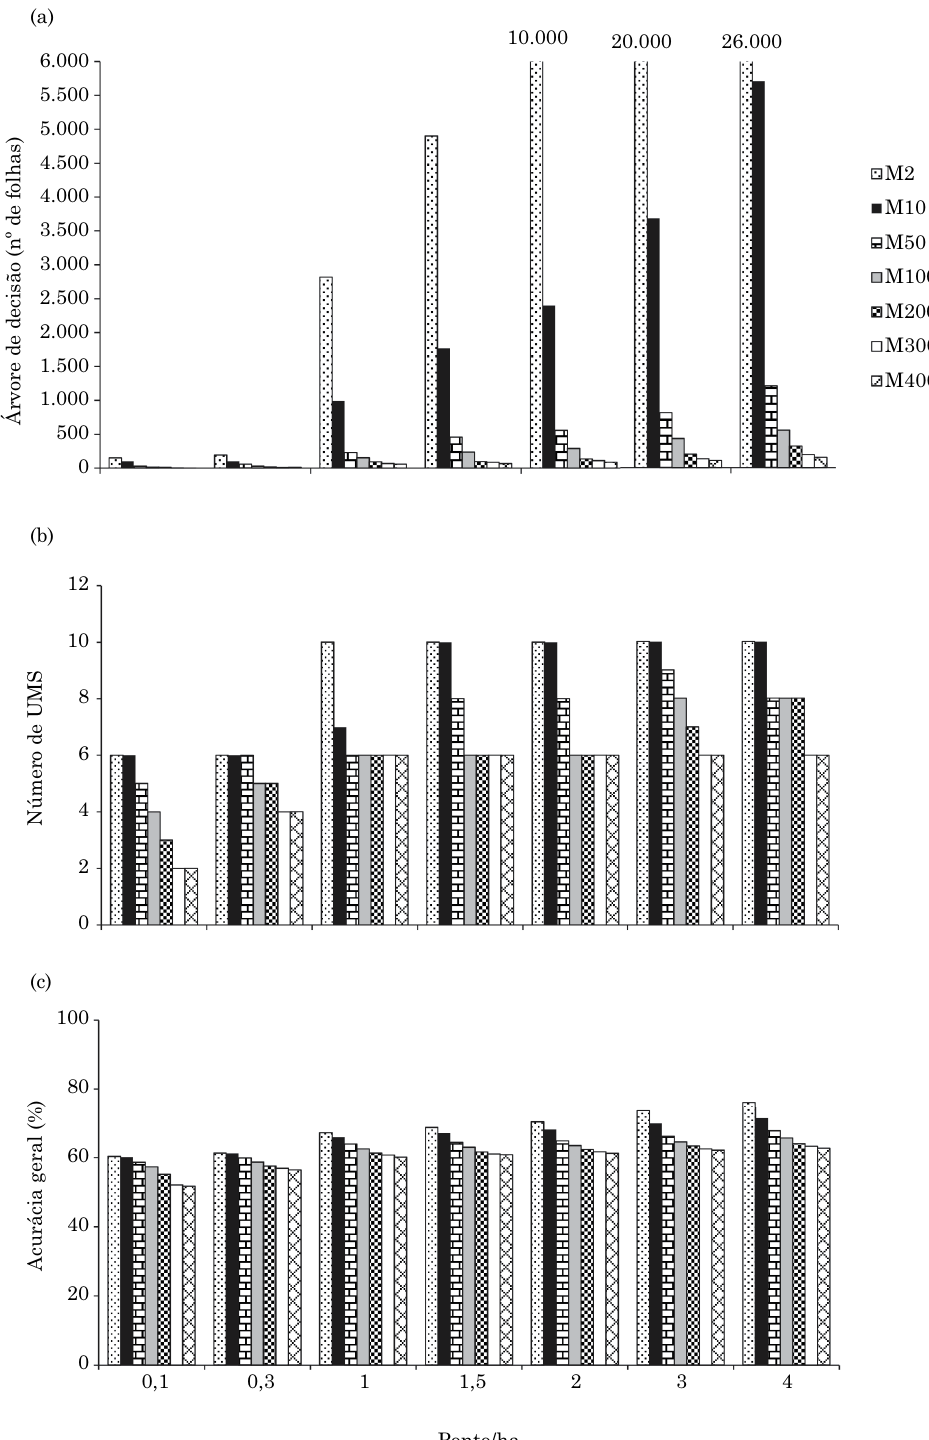
Figura 2. tamanho das árvores de decisão (a), número de unidades de mapeamento de solos (UmS) preditas (b) e acurácia geral (c) nas diferentes densidades de amostragens na bacia do rio Santo